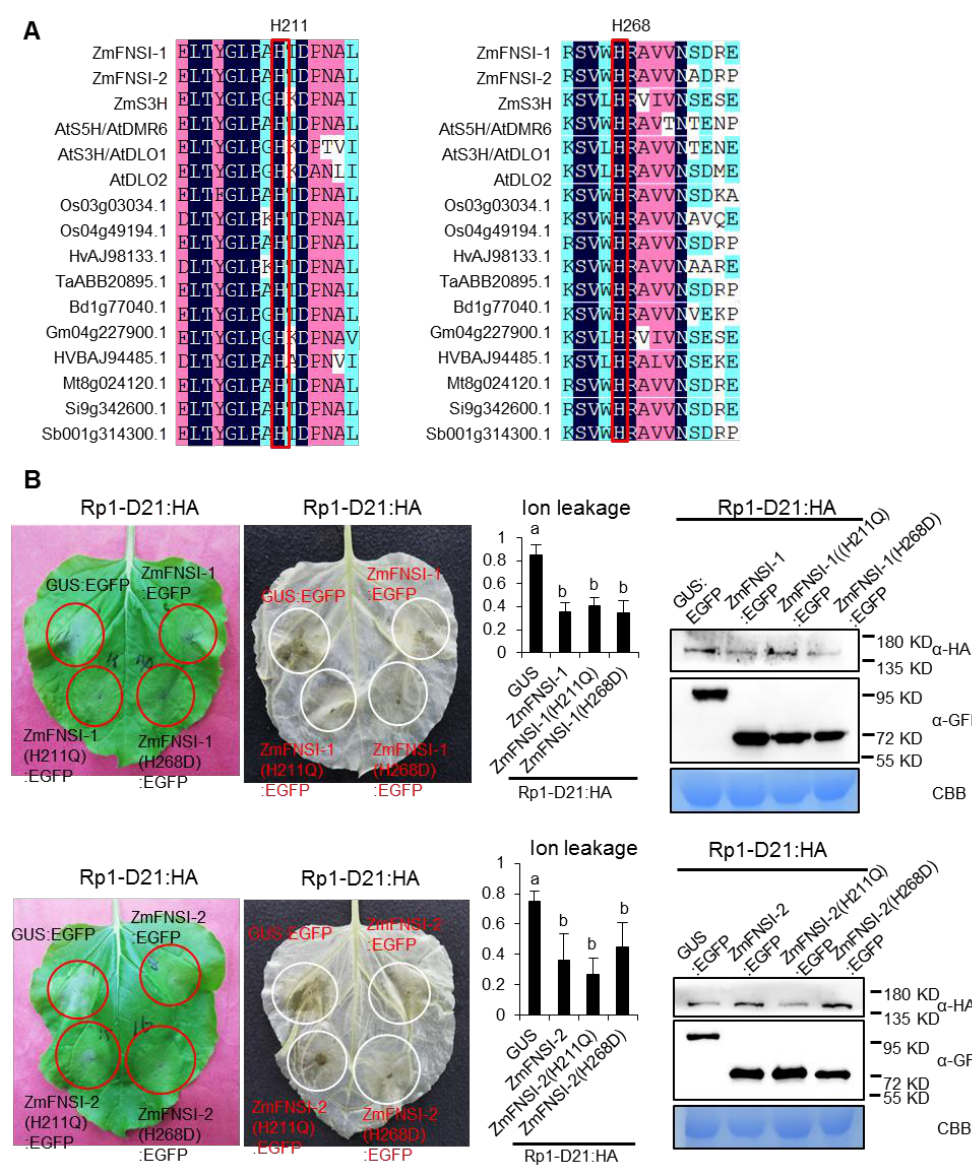
Figure 4. Mutation in the predicted catalytic active site of ZmFNSIs still suppressed Rp1-D21-mediated HR. ( A ) Multiple sequence alignments of FNSIs from di ff erent plant species were aligned by DNAMAN software. The conserved His (H) residues at position 211 and 268 of ZmFNSIs are boxed. ( B ) ZmFNSIs and their mutant derivatives were transiently co-expressed with Rp1-D21 into N. benthamiana . The representative leaf was photographed at 3 days after inoculation (left), and the same leaf was cleared by ethanol (middle). Ion leakage conductivity (average ± standard error (SE), n > 5) was measured at 61 h after co-expression of GUS and ZmFNSI-drivations with Rp1-D21. Significant di ff erences ( p < 0.05) between samples are indicated by di ff erent letters (a–b). Total protein was extracted from agro-infiltrated leaves at 48 hpi. Anti-HA was used to detect the expression of Rp1-D21, and anti-GFP was used to detect the expression of GUS, ZmFNSIs and their mutant derivatives. Equal loading of protein samples was shown by CBB staining of Rubisco.